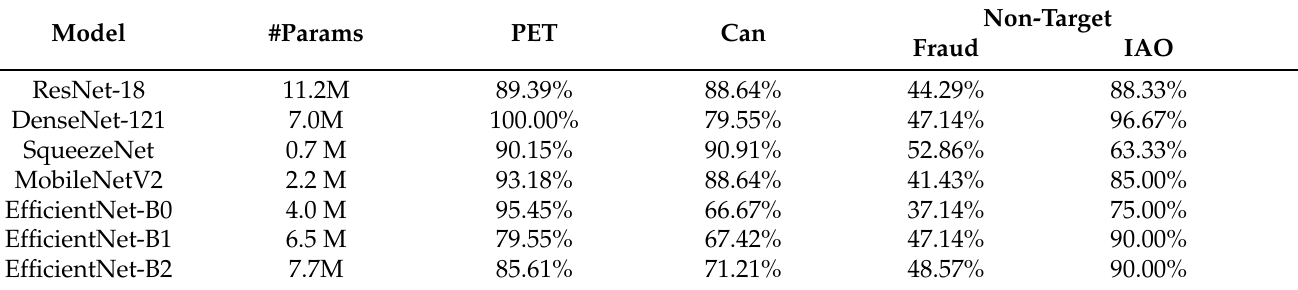
Table 4. Performance of CNNs trained with top view data, classifying objects into PET, Can, and non-target classes.